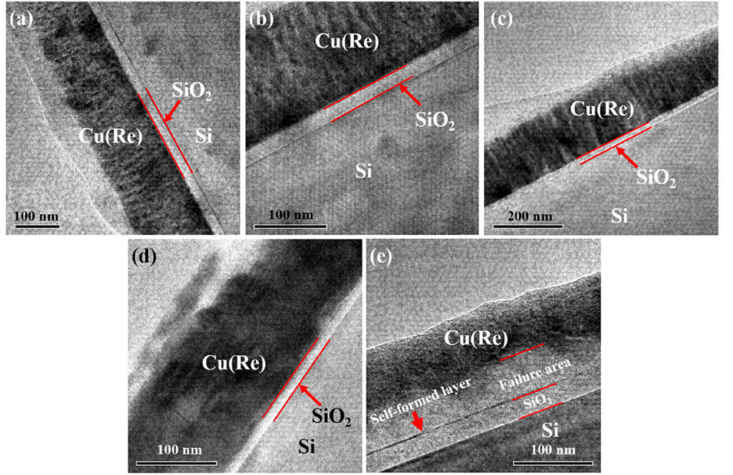
Figure 2. TEM cross-sectional images of the Cu(Re)/SiO 2 /Si interconnect structure at various temperatures: ( a ) as-deposited, ( b ) 350 ◦ C, ( c ) 450 ◦ C, ( d ) 550 ◦ C and ( e ) 650 ◦ C.